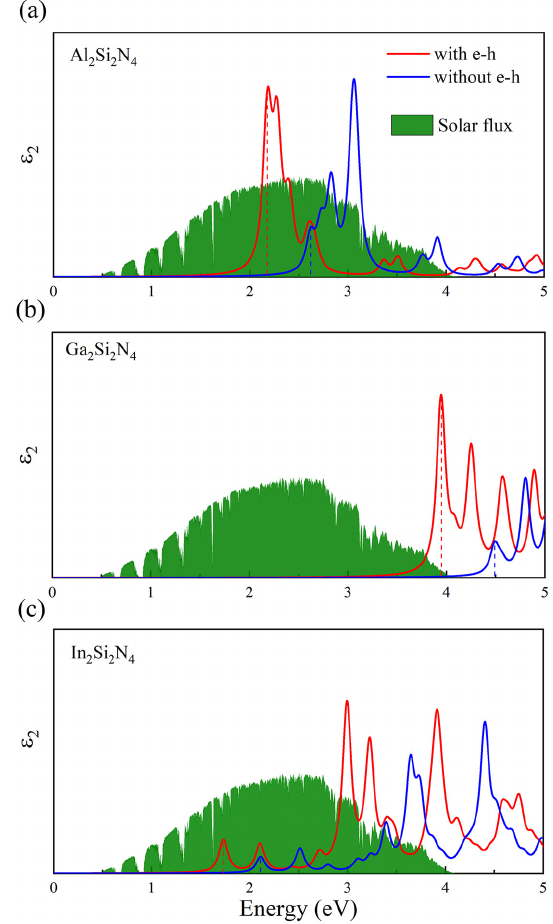
Figure 6. Imaginary part of the dielectric function of ( a ) Al 2 Si 2 N 4 , ( b ) Ga 2 Si 2 N 4 and ( c ) In 2 Si 2 N 4 . The spectra with e-h interaction and without e-h interaction were calculated on the basis of G 0 W 0 -BSE and G 0 W 0 -RPA methods, respectively. The standard AM1.5 G solar flux is shown to reflect the light capture